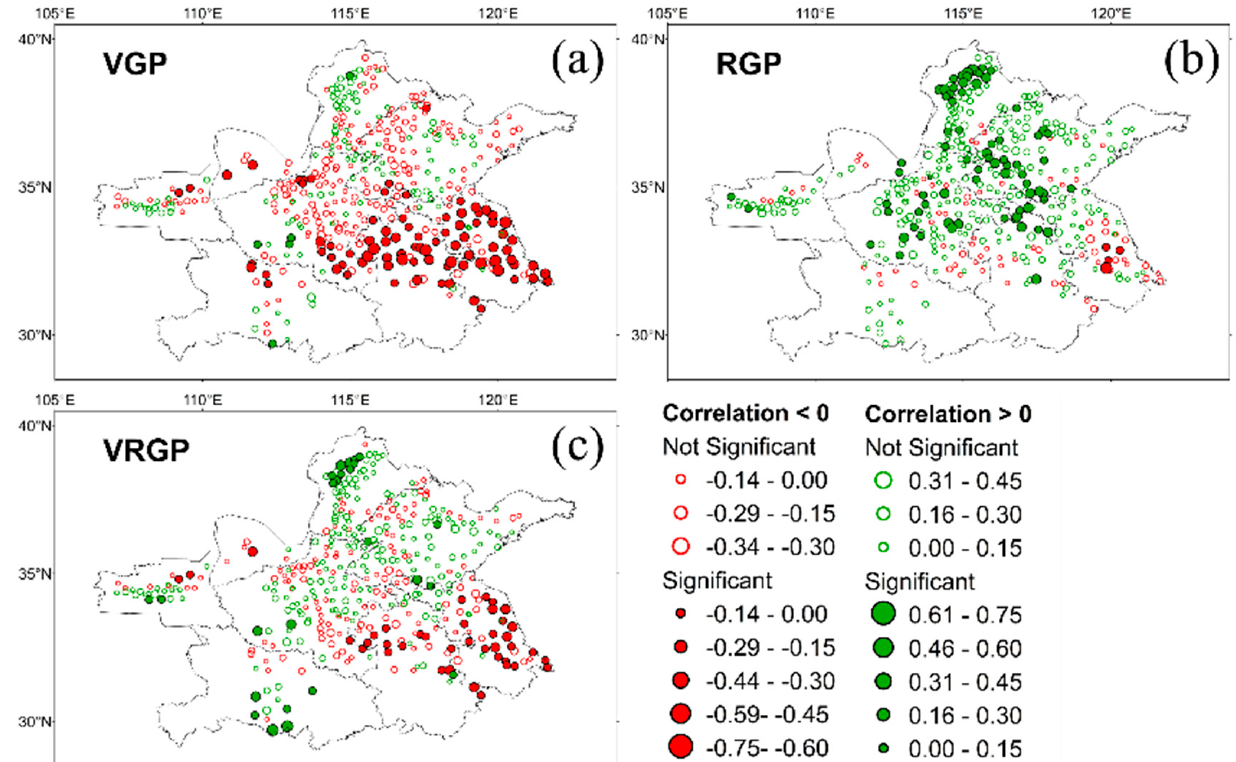
Figure 10. Correlations between different growth periods and intraseasonal temperatures from 1981 to 2016. Red circles represent negative correlations, and green circles represent positive correlations. Solid and hollow circles indicate statistically significant ( p < 0.05) and insignificant ( p > 0.05) corre- lations, respectively. ( a ) represents correlation for VGP, ( b ) represents correlation for RGP, and ( c ) represents correlation for VRGP, respectively.